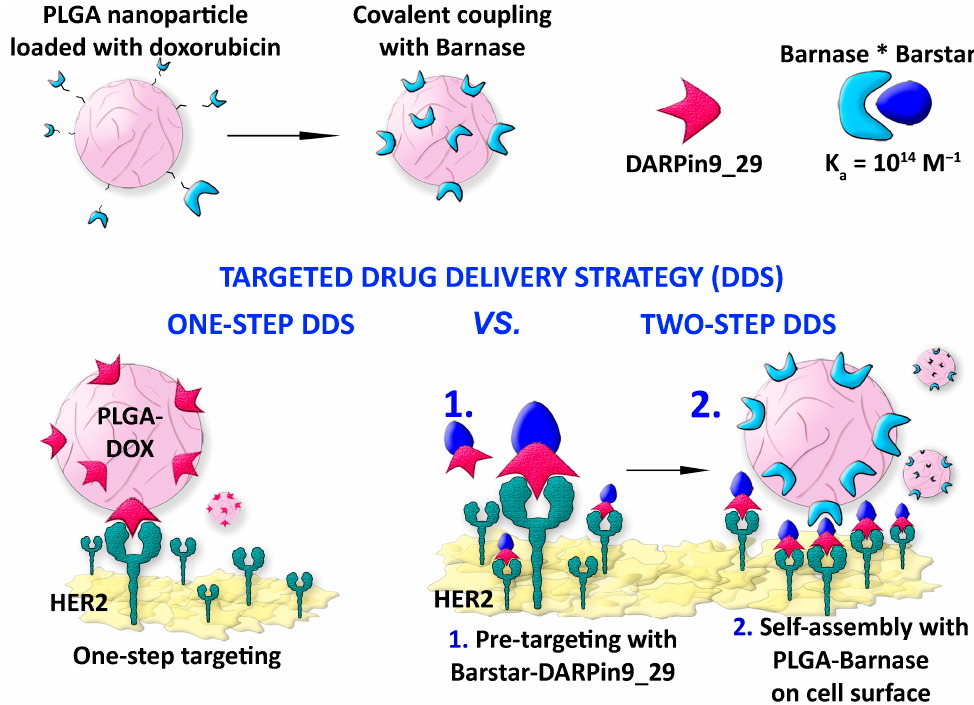
Figure 1. Scheme of the experiment. Protein-assisted one-step DDS and two-step DDS. Polymer nanoparticles loaded with the chemotherapeutic drug doxorubicin were delivered to HER2-overexpressing cancer cells. For the one-step DDS, PLGA particles were covalently modified with targeting scaffold protein DARPin9_29 that selectively recognizes receptor HER2 on the surface of cancer cells. For two-step DDS, the PLGA surface was covalently modified with barnase; then, the structure was assembled with barstar fused with DARPin9_29. The self-assembly of nanoparticles with scaffold polypeptides using protein interface barnase*barstar for the delivery to HER2-overexpressing cancer cells significantly increases the therapeutic efficacy of chemotherapy-loaded nanoparticles.